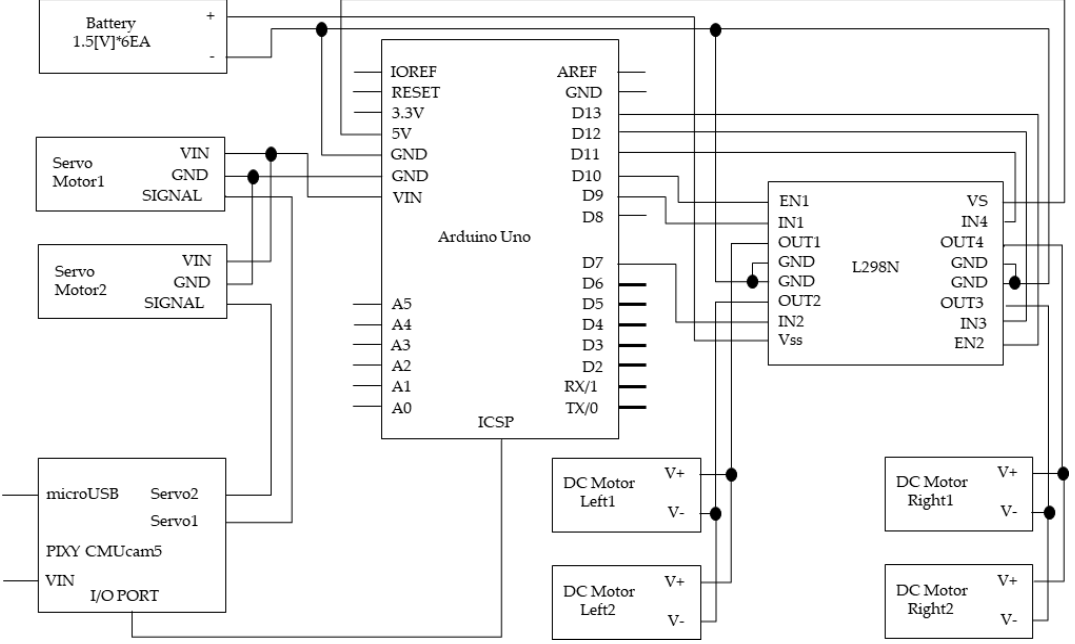
Figure 2. Schematic circuit diagram of the AGVA-Robot.